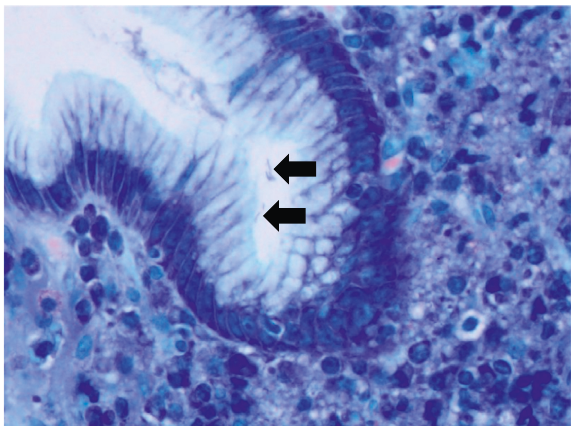
Figure 2: Histological image. Giemsa stain shows rod-shaped bacteria appearing larger than H . pylori (arrows), suggesting a non- Helicobacter pylori Helicobacter